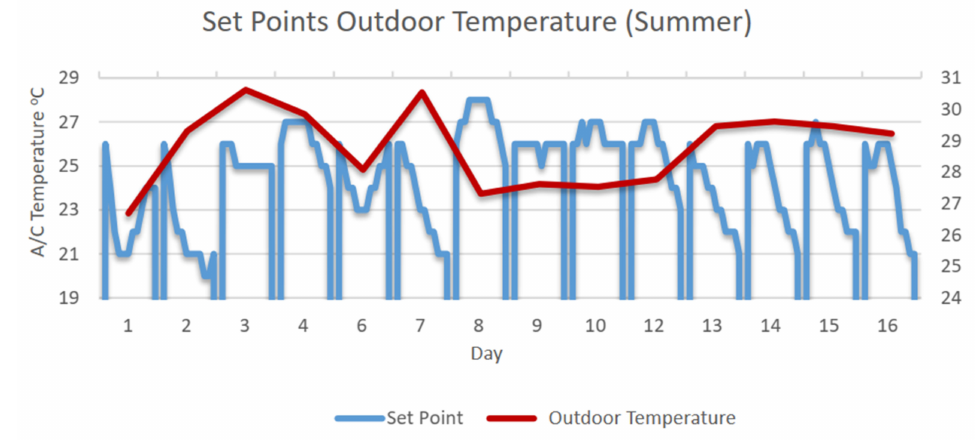
Figure 11. Set points / outdoor temperature (summer).